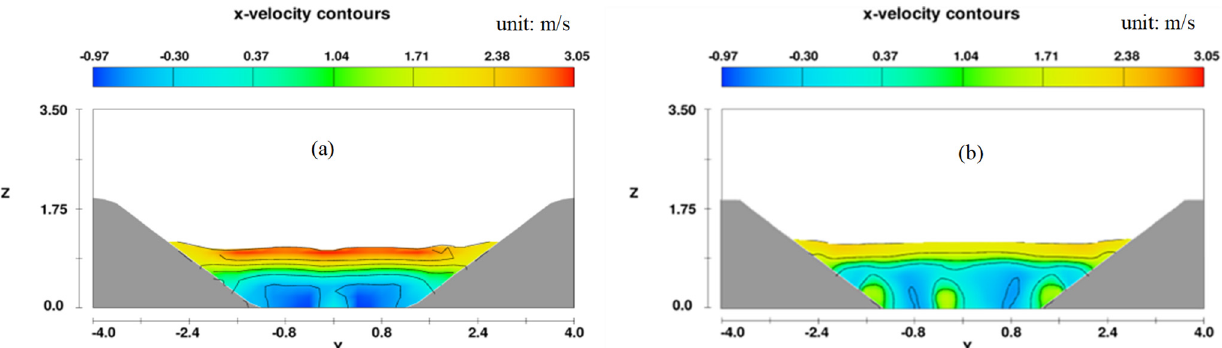
Figure 14. Velocity profiles of cross-section 3 under the two case boundary conditions. The curve of the flow velocity profile was obtained according to the numerical simulation data in Section 3, as shown in Figure 6. It is seen that because part of the flow discharging at the weir crest is transferred to the bottom, the velocity distribution in the vertical is relatively uniform (red line) and more suit- able for fish migration in Case S 2 . However, the overflow velocity of the weir crest is too large (black line) for fish migration in Case S 1 .